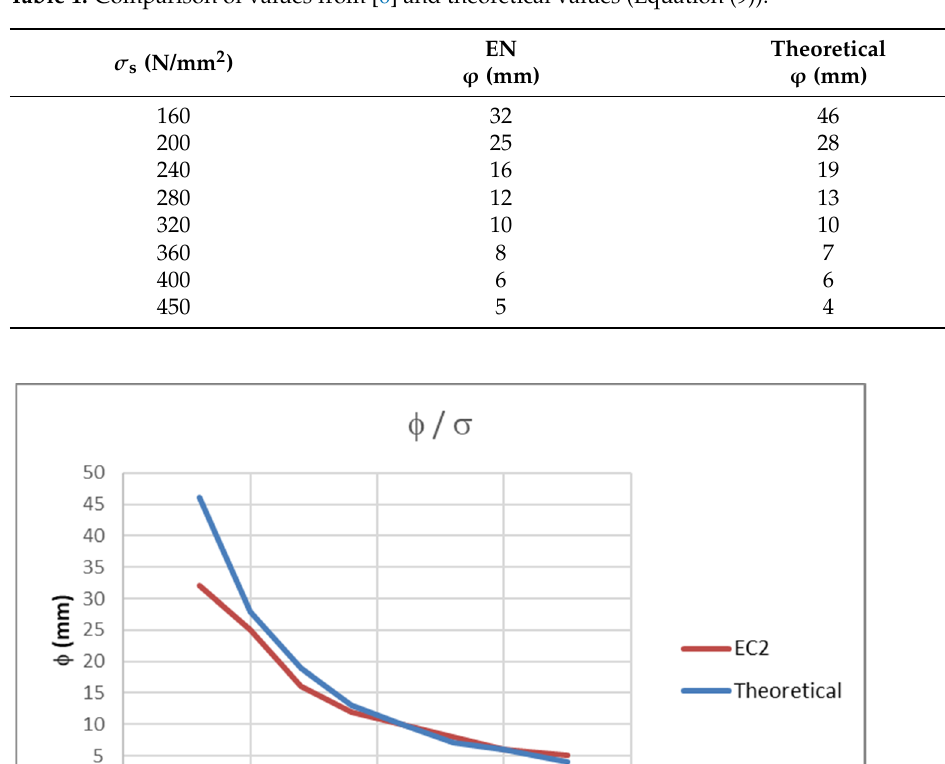
Table 1. Comparison of values from [6] and theoretical values (Equation (9)).